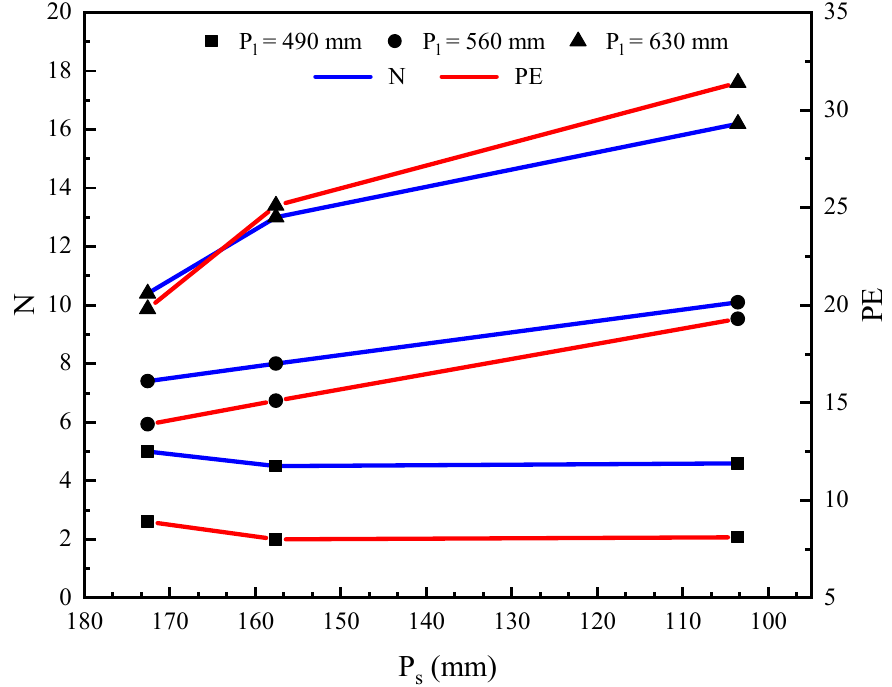
Figure 9. Plot of the effect of pole plate spacing on Pe number and model parameter N.